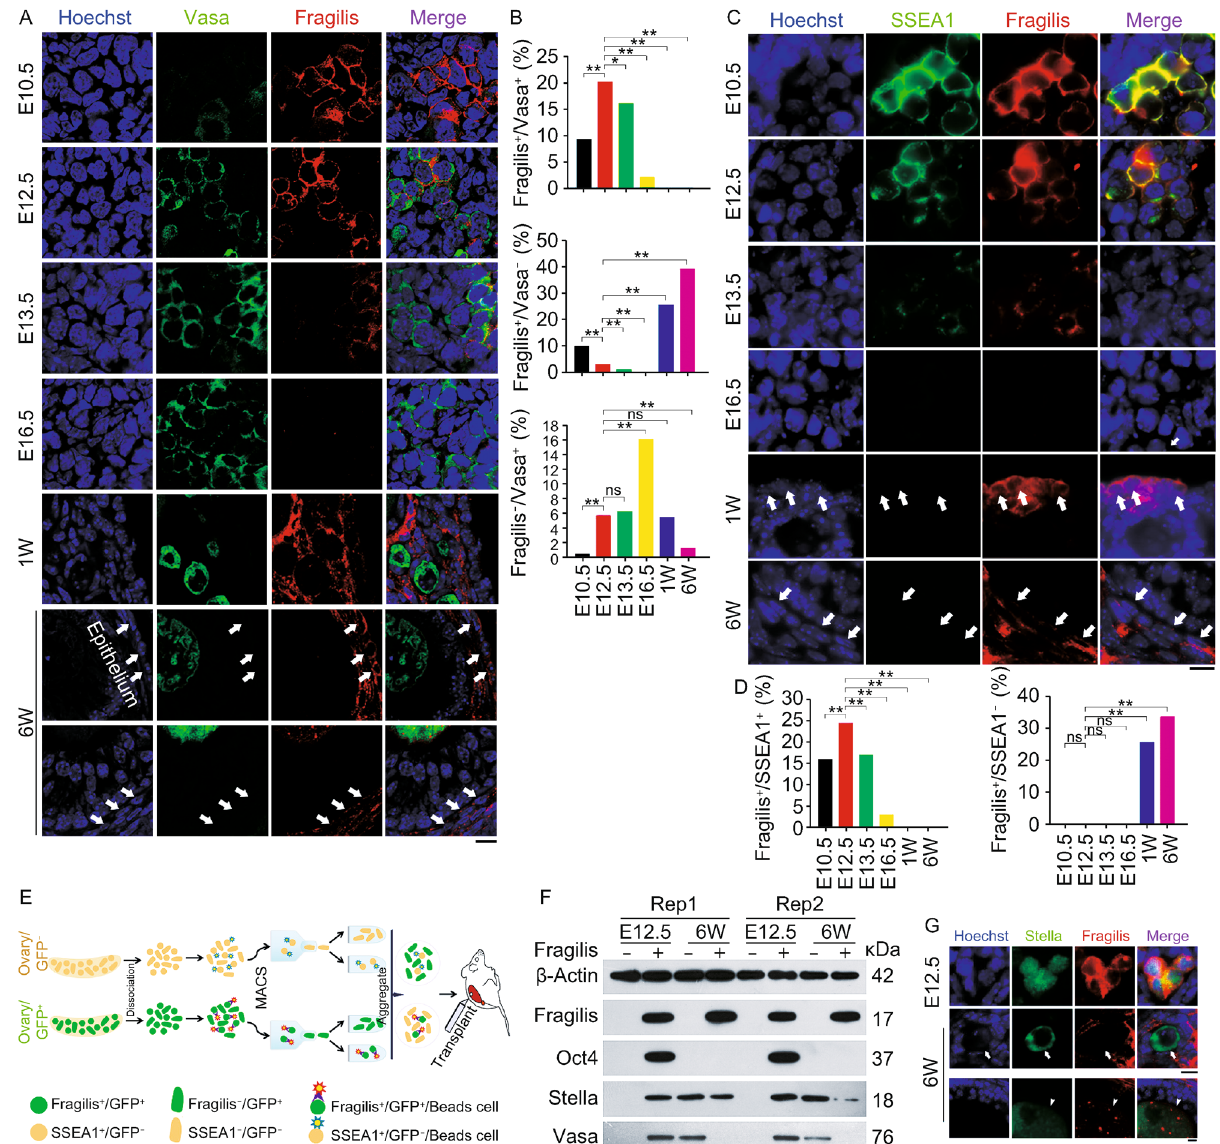
Figure 1. Expression pattern of Fragilis in mouse fetal and postnatal ovaries. (A) Representative confocal images showing co- immunostaining of Vasa (green) with Fragilis (red) in sections of E10.5, E12.5, E13.5 and E16.5 or one week (W) and 6-week old mouse ovaries. White arrows indicate Fragilis + /Vasa − cells in the epithelia, stromal or theca cells. Scale bar = 10 μ m. (B) Proportion (%) of Fragilis + /Vasa + cells, Fragilis + /Vasa − cells, and Fragilis − /Vasa + cells in mouse ovaries. X 2 test ( n ≥ 600 cells counted from three samples for each group). * P < 0.05, ** P < 0.01, compared with E12.5 gonad. ns, non-signi fi cant difference. (C) Co-immunostaining by epi- fl uorescence of SSEA1 (green) with Fragilis (red) in E10.5, E12.5, E13.5 and E16.5, or one week (W) and 6-week old mouse ovaries. White arrows indicate Fragilis + /SSEA1 − cells in the epithelia, stromal or theca cells. Scale bar = 10 μ m. (D) Proportion (%) of Fragilis + /SSEA1 + cells, and Fragilis + /SSEA1 − cells in mouse ovaries. X 2 test ( n ≥ 600 cells counted). * P < 0.05, ** P < 0.01, compared with E12.5 ovaries. Three repeats. (E and F) Isolation and characterization of Fragilis + cells sorted from mouse ovaries. (E) Overview of the protocol for isolation of Fragilis + cells and experimental design for transplantation. (F) Protein expression levels by Western blot of Fragilis, Oct4, Stella and Vasa in Fragilis + cells and Fragilis − cells from E12.5 and 6-week mouse ovaries. β -Actin served as loading control. (G) Co-immuno fl uorescence of Stella (green) and Fragilis (red) in E12.5 and 6-week old mouse ovaries. Stella mainly in nuclei and Fragilis on the membrane are co-expressed in E12.5 ovaries. In 6-week mouse ovaries, Stella is localized in the cytoplasm of oocytes. Most of Stella positive oocytes are Fragilis negative (white arrows), and few are also positive for Fragilis in which Fragilis is expressed in the cytoplasm of oocytes of secondary and mature/antral follicles (white arrowheads). Scale bar = 10 μ